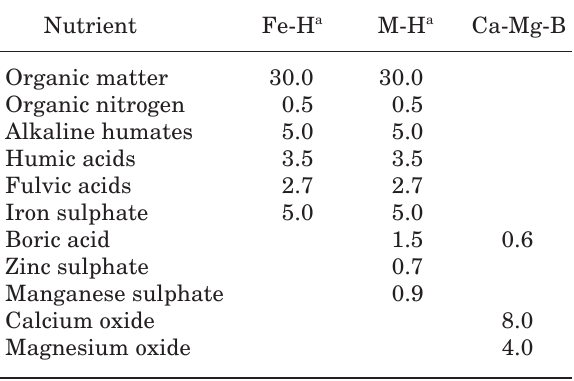
Table 4. Composition of foliar fertilisers as Iron humate (Fe-H), Microelement humate (M-H) and Ca-Mg-B so- lution.